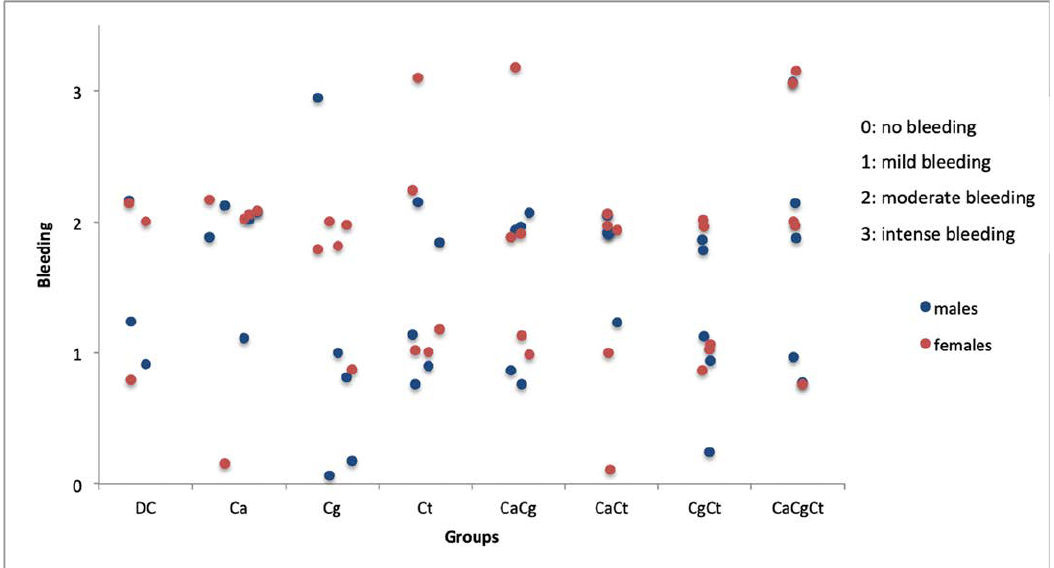
Figure 5. Bleeding of the gingival sulcus region after removal of the acrylic device. DC: device control, Ca: Candida albicans , Cg: Candida glabrata , Ct: Candida tropicalis , CaCg: C. albicans + C. glabrata , CaCt: C. albicans + C. tropicalis , CgCt: C. glabrata + C. tropicalis , and CaCgCt: C. albicans + C. glabrata + C. tropicalis groups.